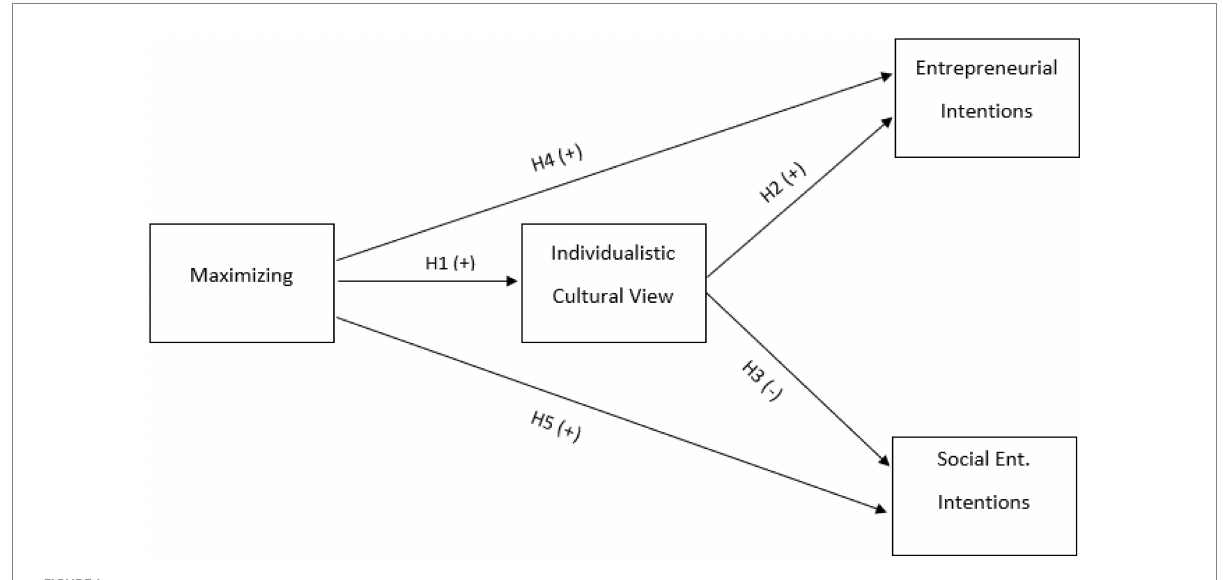
FIGURE 1 Research